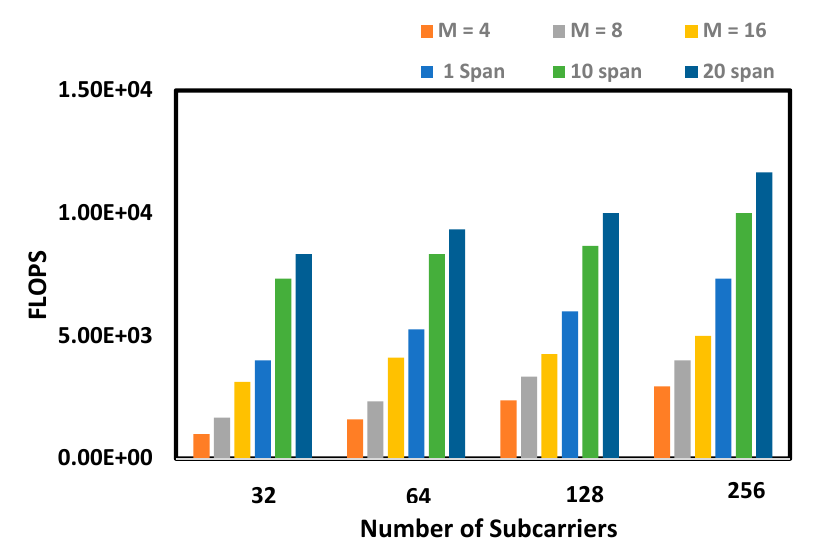
Figure 8. Computational complexity comparison between ANN-NLE and IVSTF-NLE versus the number of sub carriers, whereas the M-ASK modulation formats (M = 4, 8, and 16) corresponds to the ANN-NLE FLOPS and the 1 span, 10 span and 20 spans corresponds for the IVSTF-NLE FLOPS.